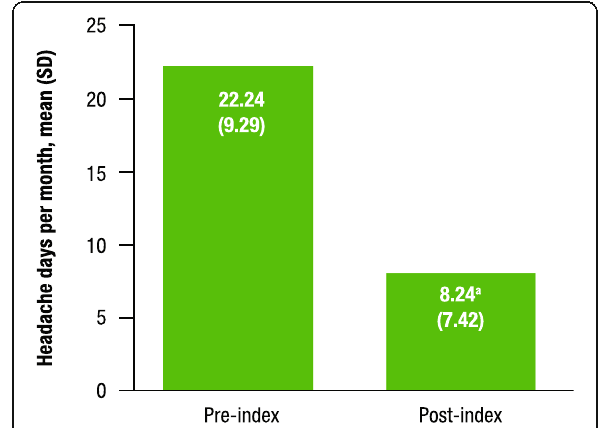
Fig. 1 Change in headache frequency. SD, standard deviation. a P < 0.001 for pre-index vs.